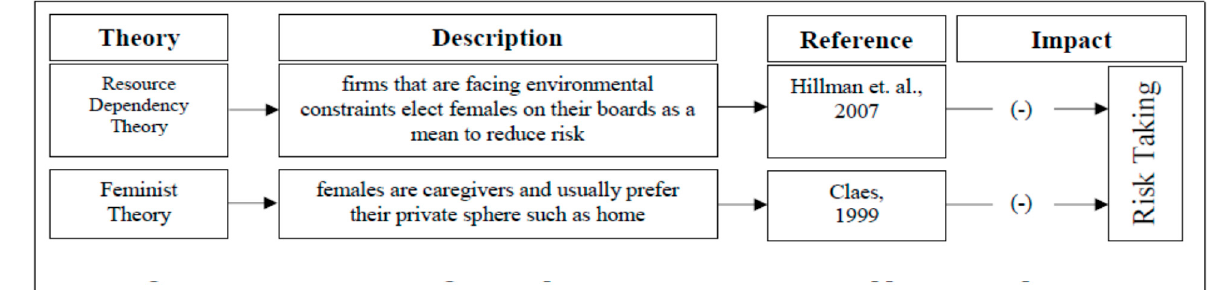
Figure A2. Firm risk-taking: conceptual model based on multi-approach perspective.